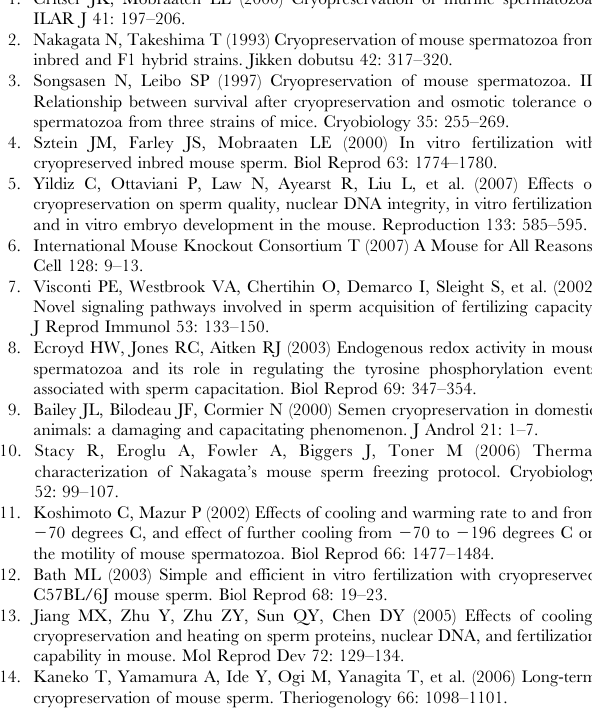
Table S4 Data set for sperm cryopreserved and recovered using a method modified from Sztein et